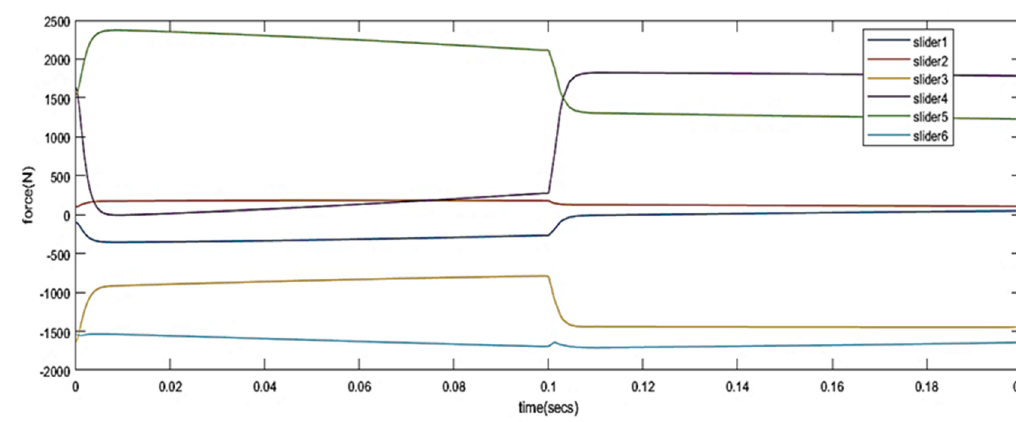
Figure 9. Step acceleration signal.